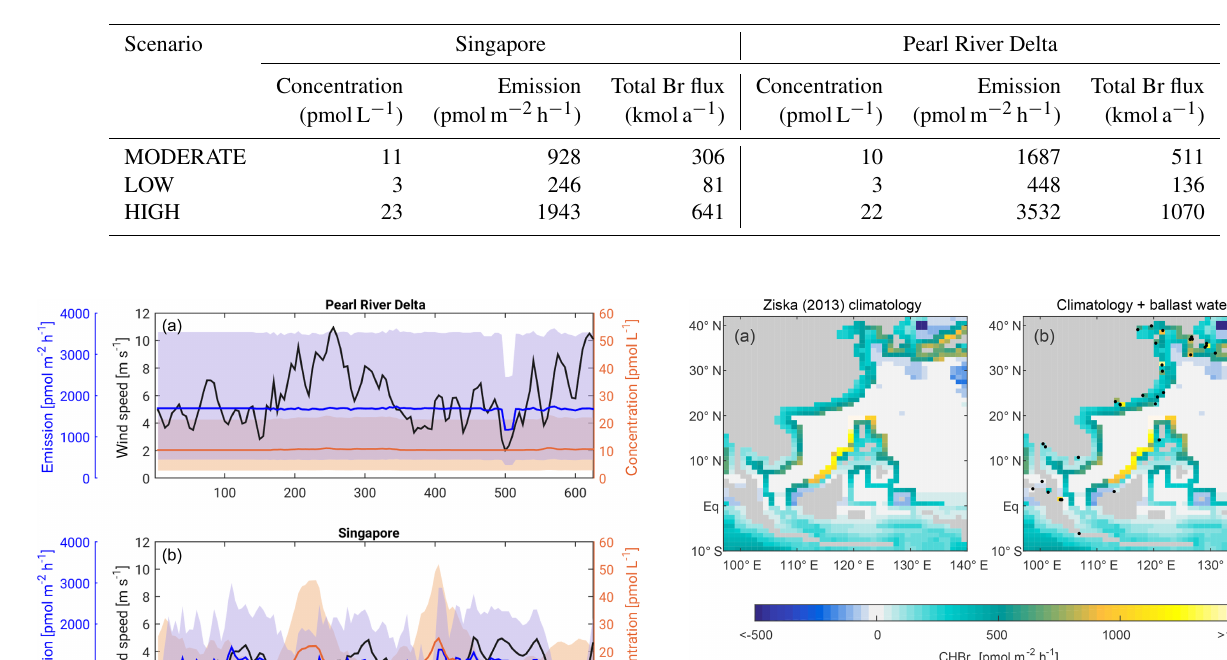
Table 3. Average values for the FLUX experiment in Singapore and the Pearl River Delta region for different scenarios. Values are calculated as the sum of three grid boxes around the discharge location.